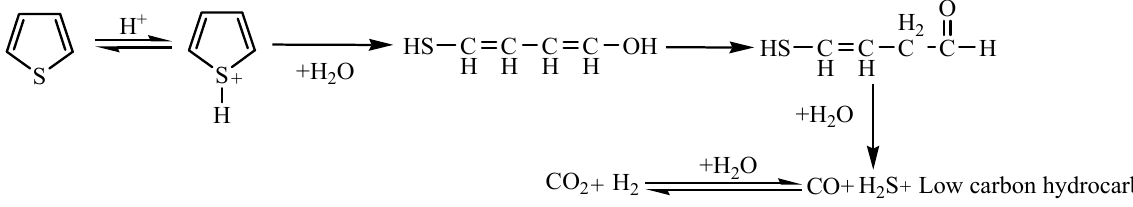
Figure 11. Diagram of the aquathermolysis reaction mechanism of thiophene.